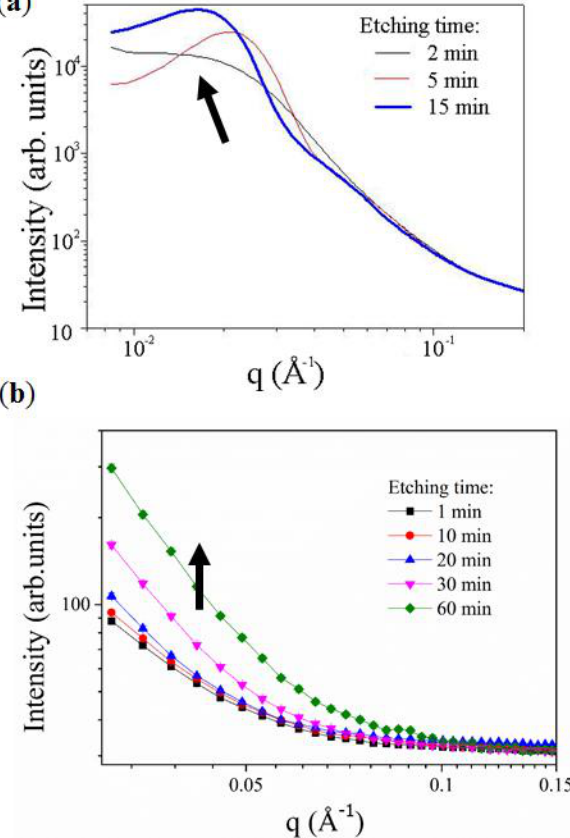
Figure 5. Small angle X-ray scattering (SAXS) analysis of in situ DA experiment on: ( a ) AuAg 50 ; and ( b ) CuZn 15